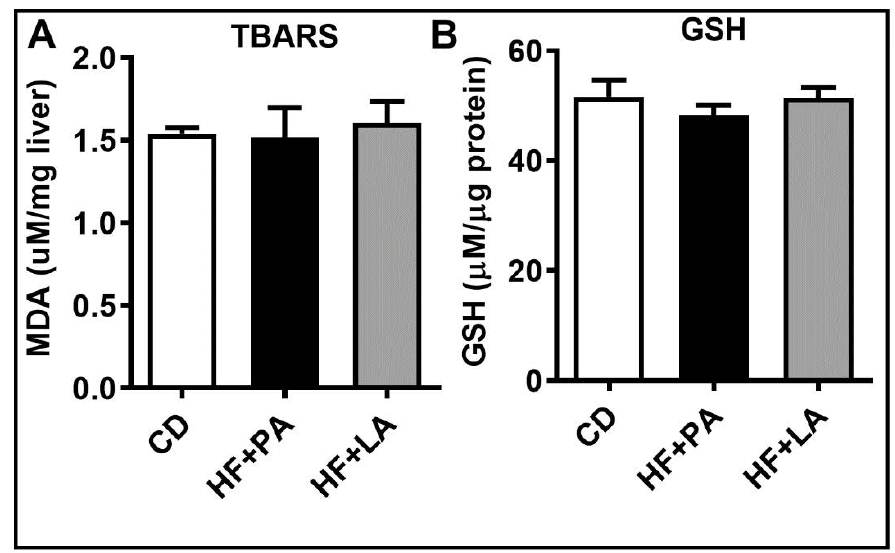
Figure 7. Effect of HF diet supplemented with PA or LA on markers of hepatic oxidative stress. The degree of lipid peroxidation was assessed through measurement of TBARS ( A ). Hepatic levels of total GSH are shown ( B ). Values are expressed as mean ± SEM of 6–8 samples in each group. MDA, malondialdehyde; TBARS, thiobarbituric acid reactive substances; GSH, glutathione; CD, chow diet; HF + PA, high fat + palmitic acid; HF + LA, high fat + lauric acid.